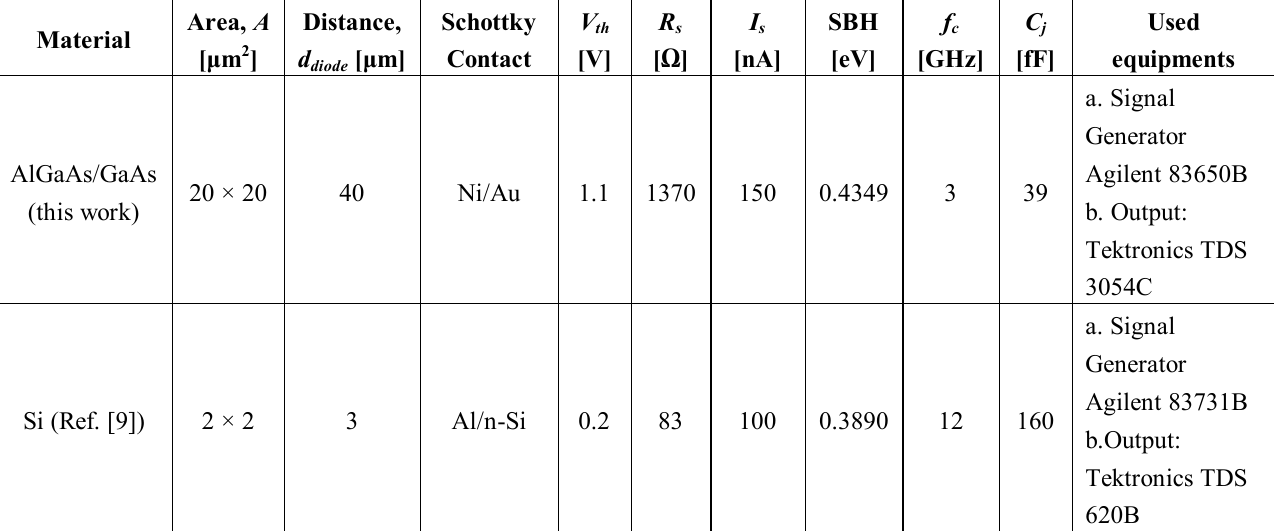
Table 1. Physical characteristics of AlGaAs/GaAs HEMT Schottky diode and Si Schottky diode.